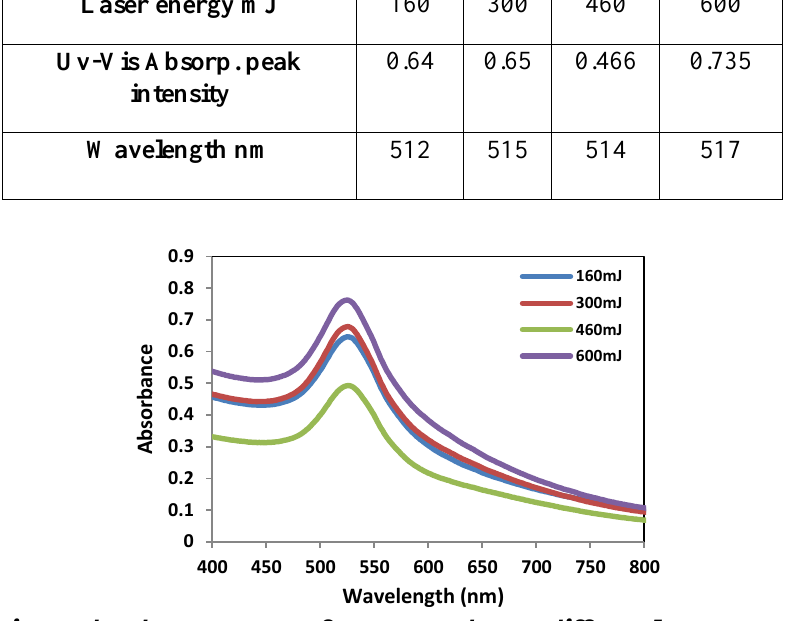
Fig. 6: Absorbance spectra of AuNPs produce at different laser energy.